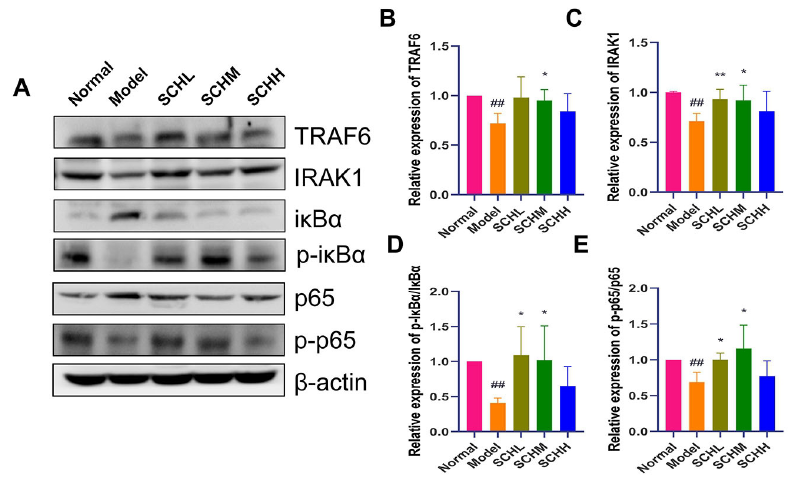
Figure 5. The effect of SCH on the relative expression levels of TRAF6 ( B ), IRAK1 ( C ), p−iκB−α/iκB−α ( D ), and p−p65/p65 ( E ) in immunosuppressed mice and the image of the above pro- tein bands ( A ). The results are presented as the means ± SD (n ≥ 3). ## p < 0.01 compared with the normal group, * p < 0.05, ** p < 0.01 when compared with the model